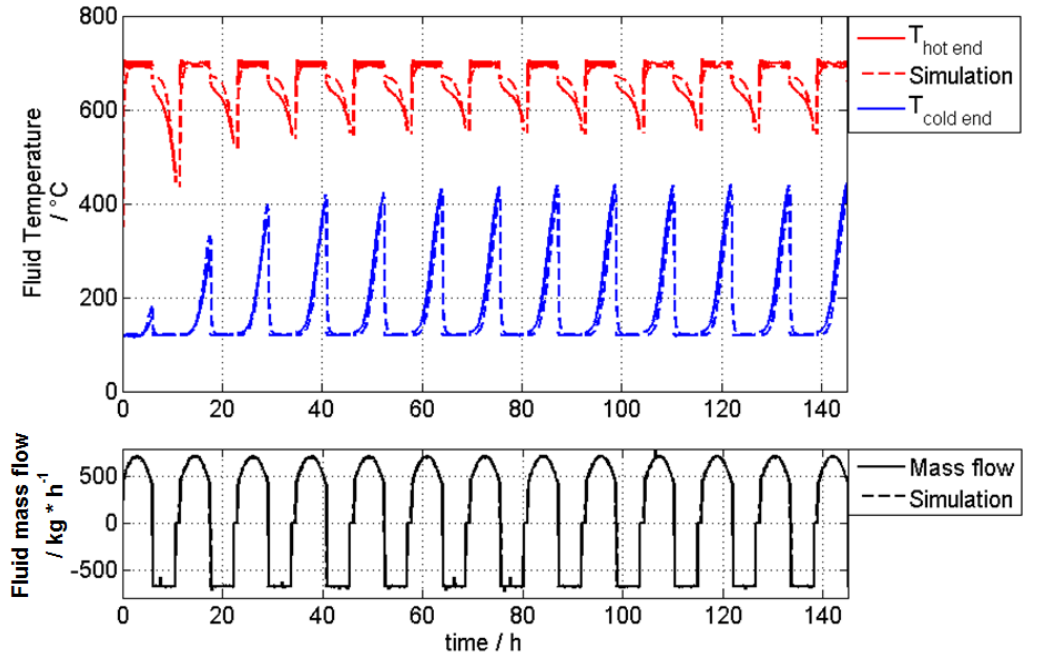
Figure 10. 21 June: Fluid temperature at TES cold end (blue) and hot end (red), mass flow while charging and discharging (black); solid lines represent the experimental results and dashed lines show the simulation model results.